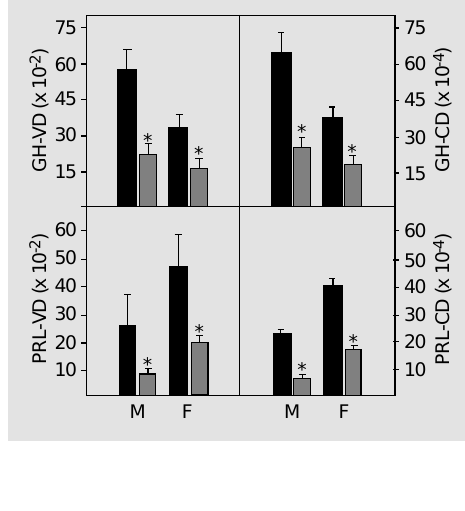
Figure 3 - Volume density (VD) and cell density (CD) of LH and FSH cell populations in male (M) and female (F) monkeys from the control (black bars) and un- dernourished (gray bars) groups. *P<0.05 compared to control (LSD test for multiple compari- sons).